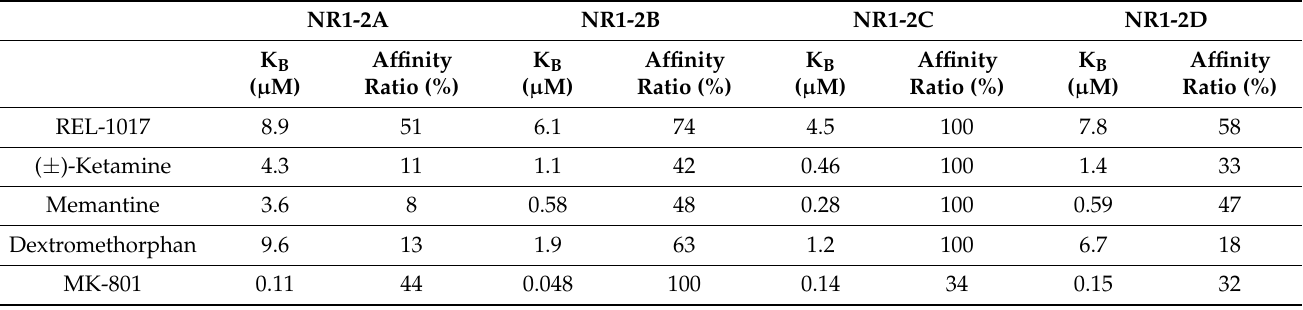
Table 2. K B and affinity ratio values of REL-1017 and reference NMDAR